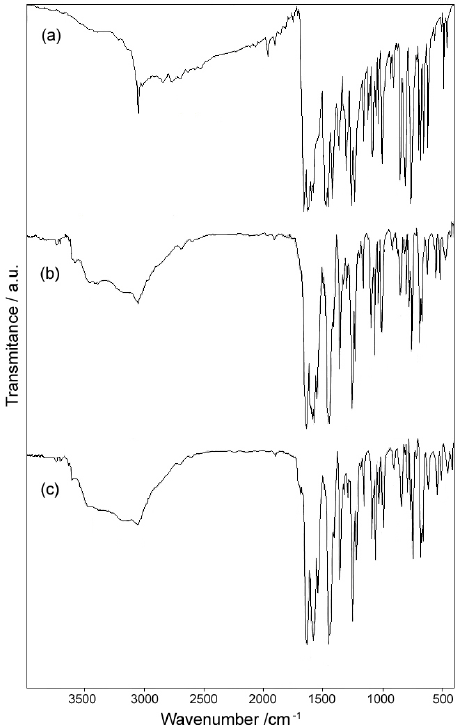
(H O) ]·0.5H 2 2 2 2